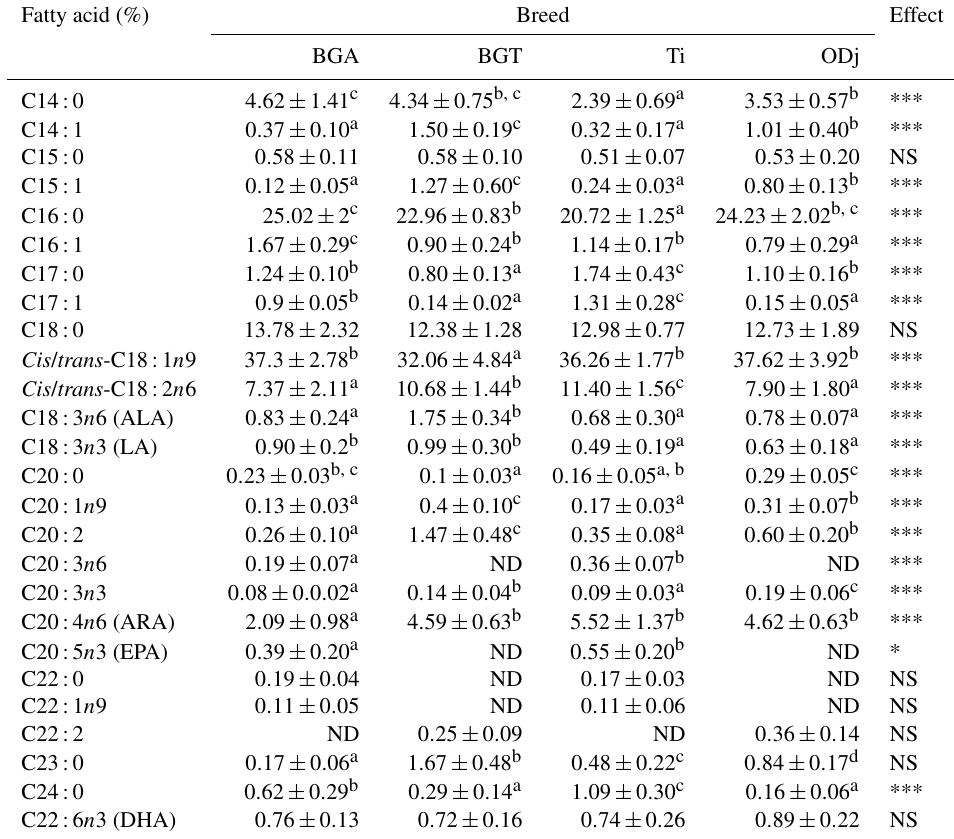
Values in the same row with different superscripts are significantly ( p < 0 . 05 ) different. NS: not significant; ND: not detected; ∗ p < 0 . 05 ; ∗∗ p < 0 . 01 ; ∗∗∗ p < 0 . 001 ; BGA: female lambs of Beni Guil breed sampled in the Ain Beni Mathar region; BGT: female lambs of Beni Guil breed sampled in the Tendrera